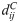
The Canberra distances dijC toward the USA versus time, for each of the 11 countries analyzed, t ∈ [1960, 2015], and weights αk = {1, 1, 1}.The clusters C1 = {AUS, CAN, CHE, FRA, GBR, JPN, USA} and C2 = {BRA, CHN, IND, MEX, ZAF} are visible.